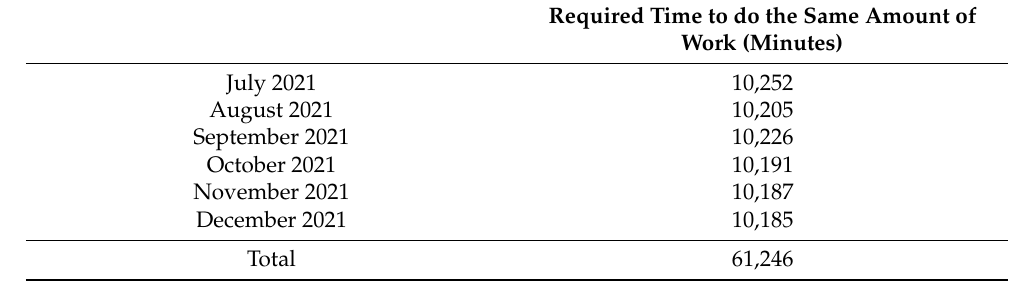
Table 6. Daily working time required to do the same amount of work after using the DT. Required Time to do the Same Amount of